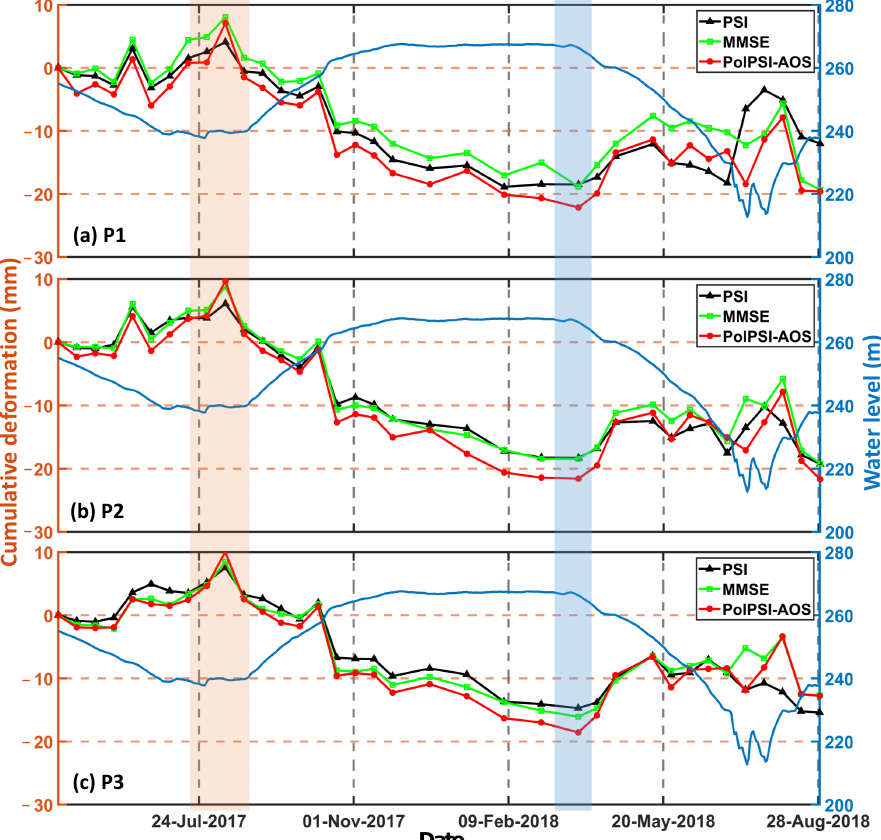
Figure 16. The three methods obtained time series deformations of the three selected pixels (i.e., P1, P2, and P3), which are along with the profile over the dam front in Figure 15d. The reser- voir basin water level of the same observing duration is also depicted for the analysis of the dam deformation